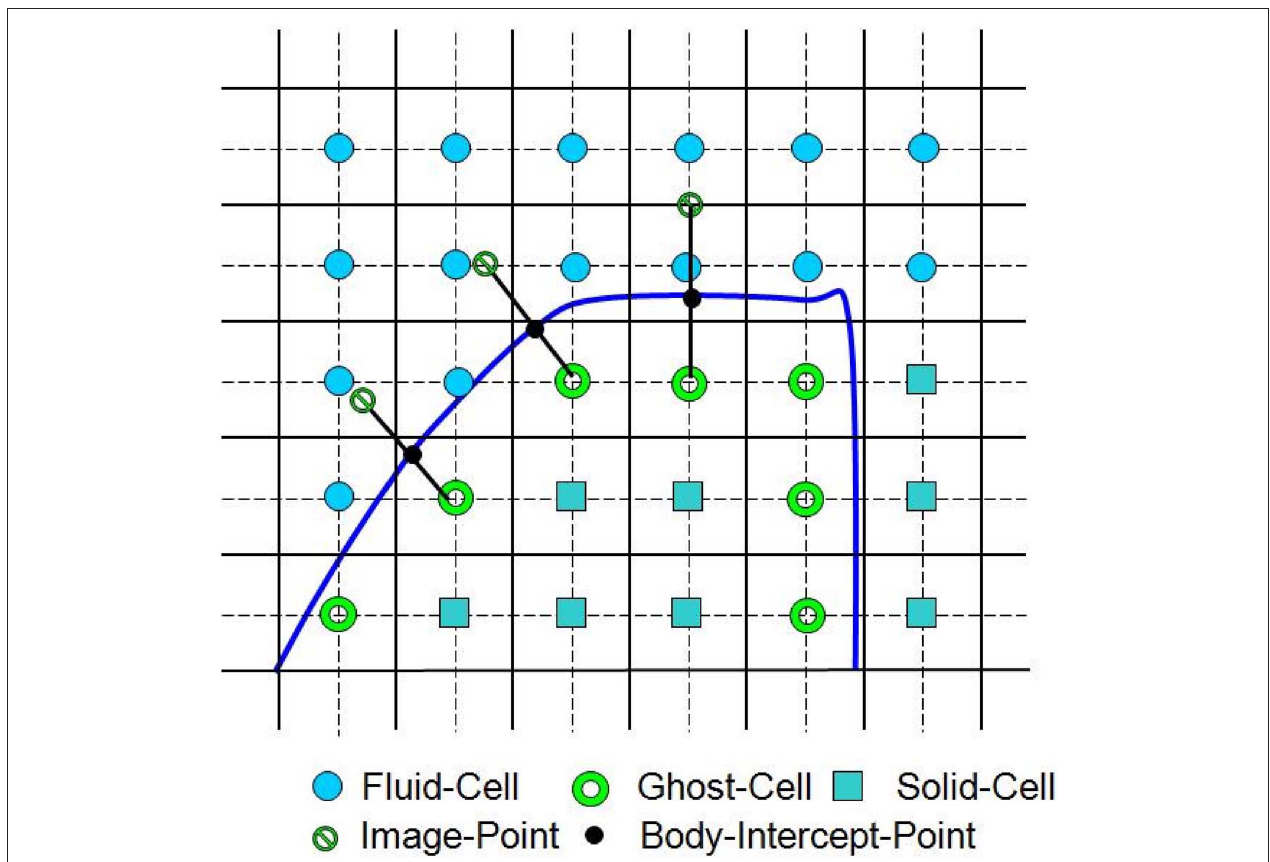
Figure 6 | Schematic describing ghost-cell methodology (adapted from Zheng et al., 2010